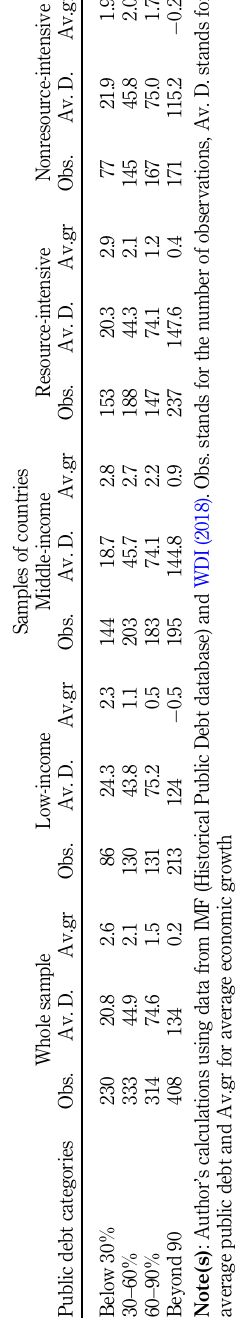
Table 1. Real per capita GDP growth as the level of public debt varies in Africa, 1980 –